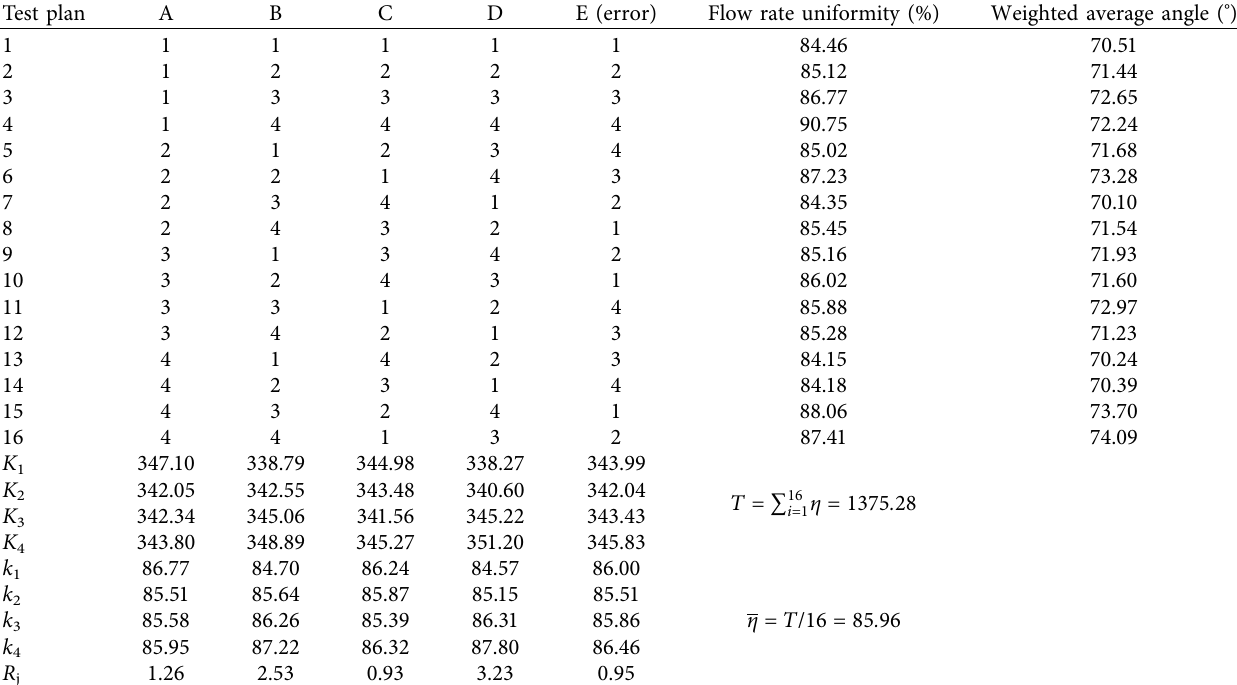
Table 2: Test plan and calculation